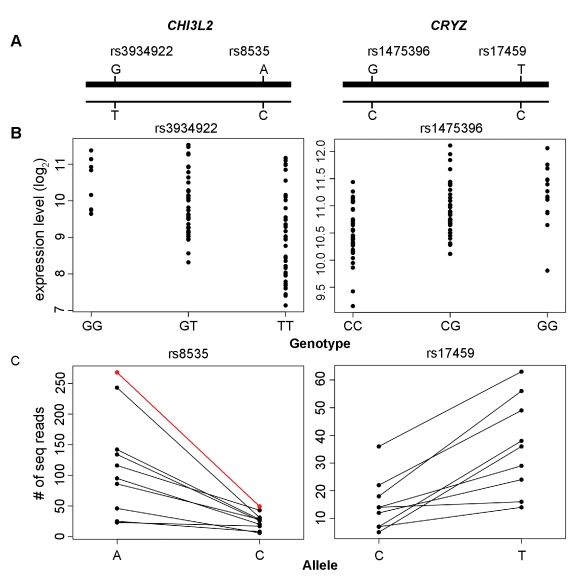
Allelic expression from RNA-Seq confirms prediction by association analysis.Graphical presentations of two genes that show differential allelic expression. The thick lines represent the higher expressing allelic forms of CHI3L2 and CRYZ (A). Regression of expression phenotypes (expression levels shown on vertical axis) of two genes on nearby SNPs (genotypes shown on horizontal axis) (B). Number of reads (vertical axis) from RNA-Seq for each allelic form (horizontal axis) of the genes; only data for individuals who are heterozygous at the coding SNPs are shown. For each individual, the number of reads for each allele of an SNP is connected by a line. For example, in the panel for rs8535 (CHI3L2), the individual represented by a red line had 268 reads of the A-bearing form of CHI3L2 and 49 reads of the C-bearing form of CHI3L2 (C).